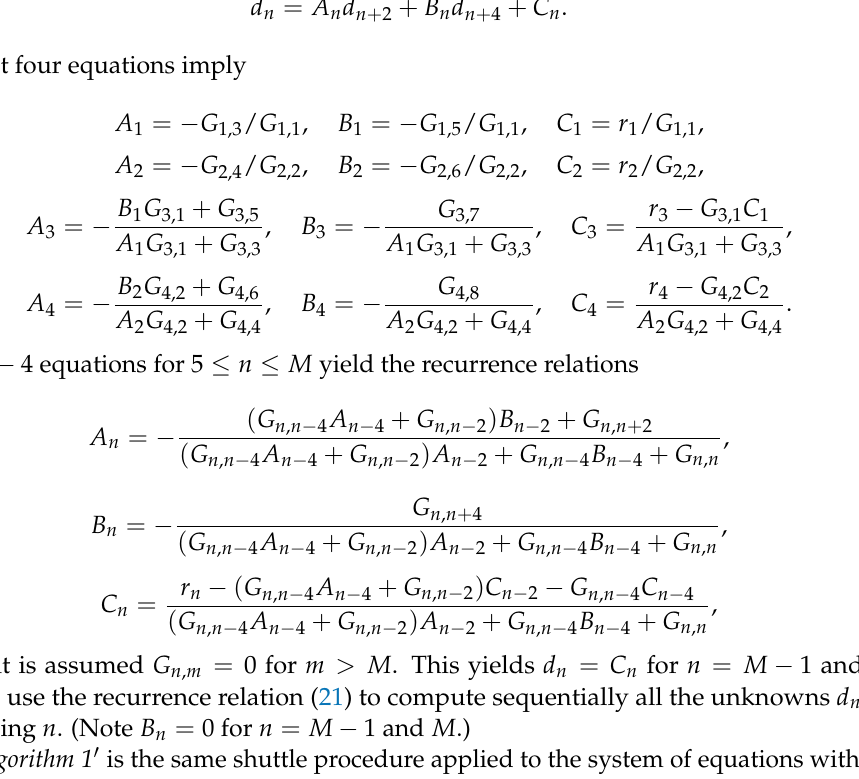
Algorithm 1 (cid:48) is the same shuttle procedure applied to the system of equations with the reverse numbering of equations and